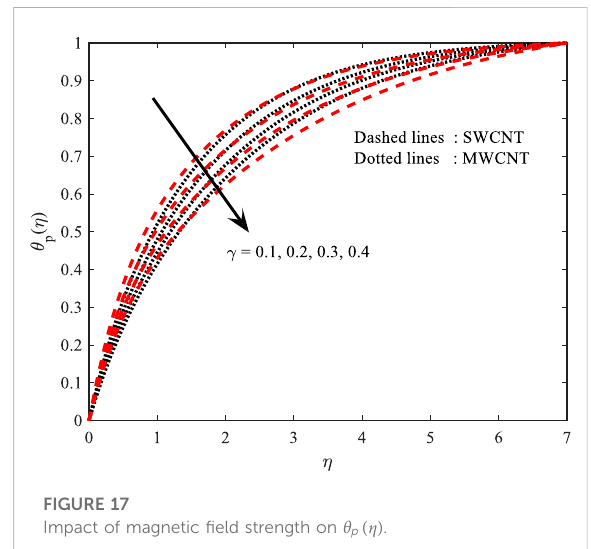
FIGURE 17 Impact of magnetic fi eld strength on θ p ( η )